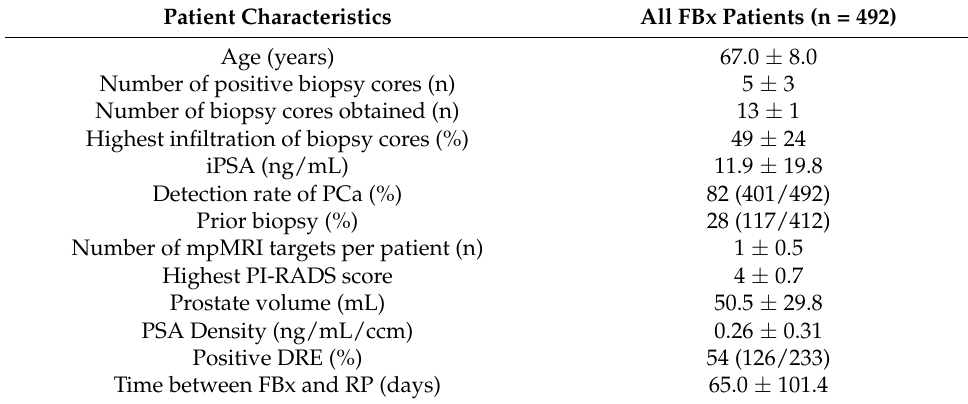
Table 1. Patient characteristics of the 492 included FBx patients. Data are shown as mean and standard deviation (SD) or as ratio in percent. FBx: mpMRI–ultrasound fusion-guided prostate biopsy, RP: radical prostatectomy, iPSA: prostate-specific antigen at FBx, DRE: digital rectal